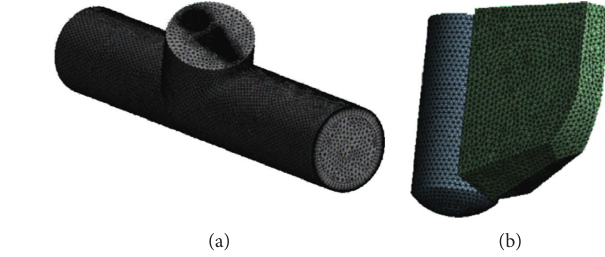
Figure 16: Geometric model.